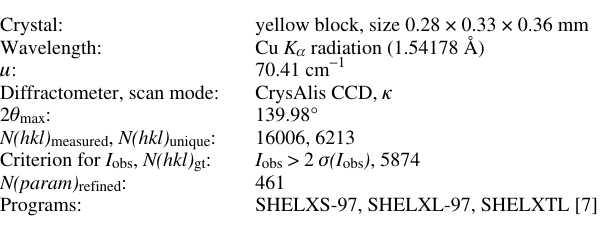
Table 1. Data collection and